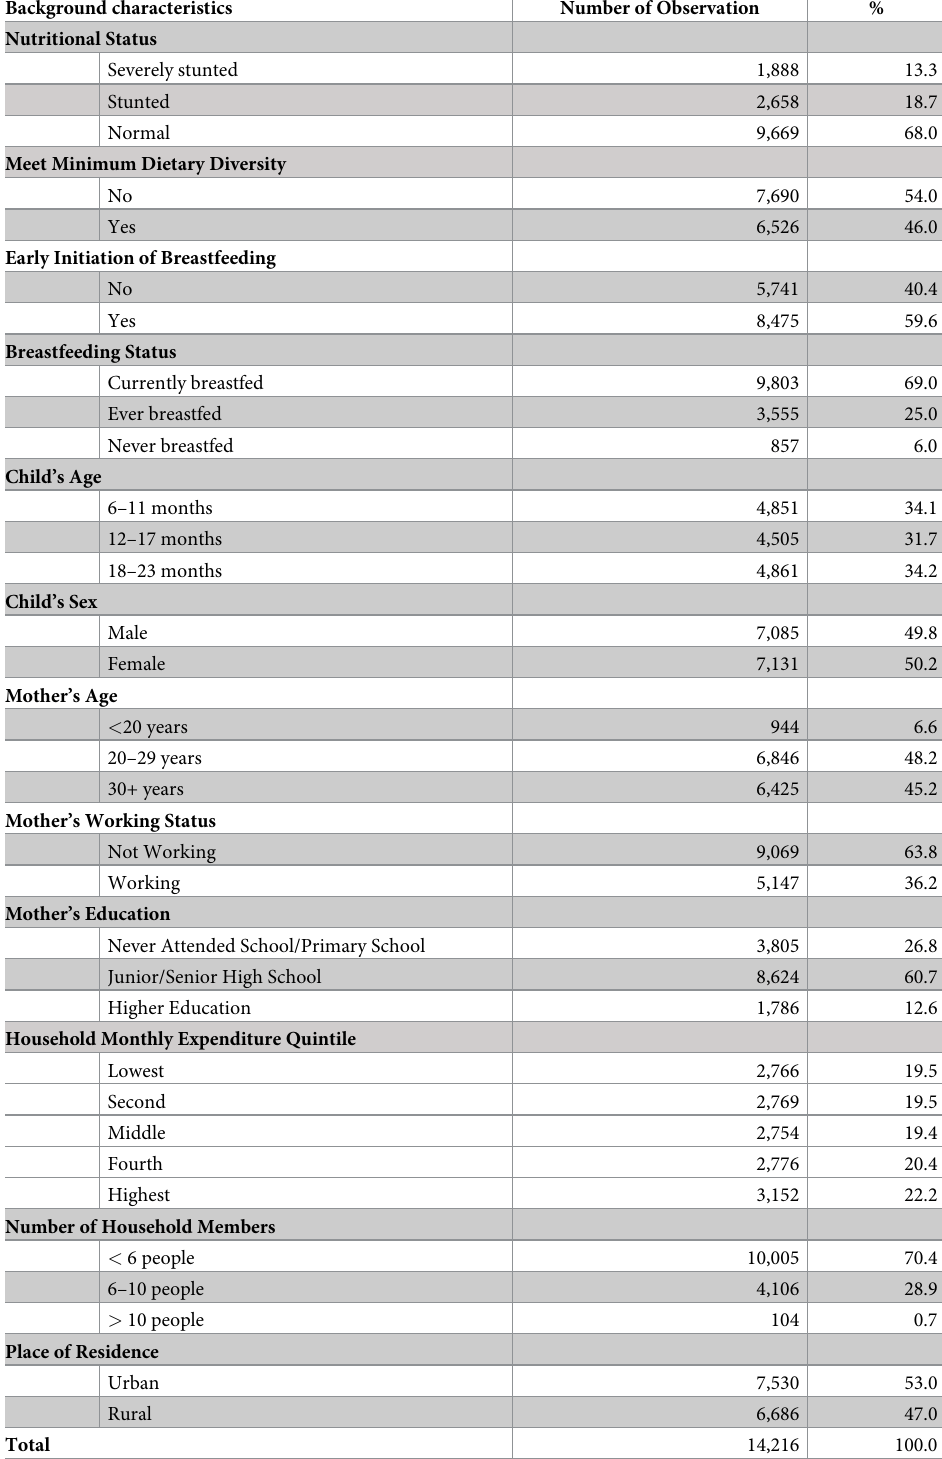
Table 2. Percentage distribution of infants and children aged 6–23 months by background characteristics, RIS- KESDAS